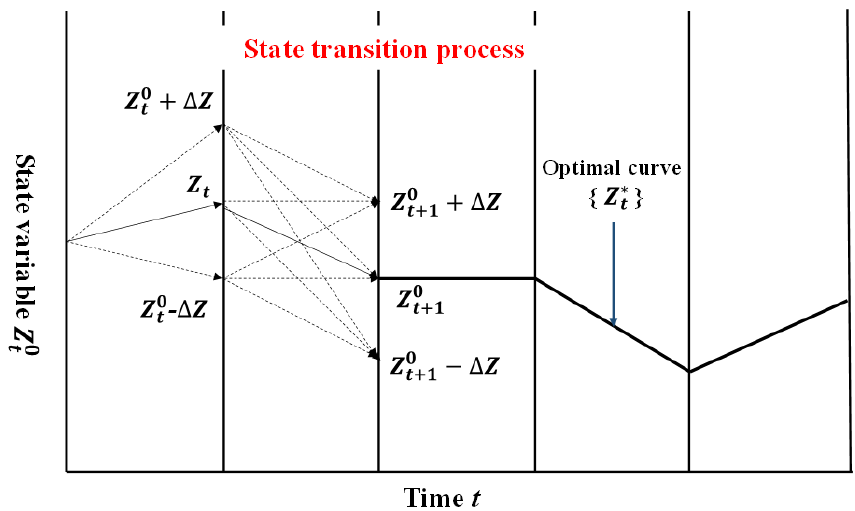
Figure 5. Schematic diagram of